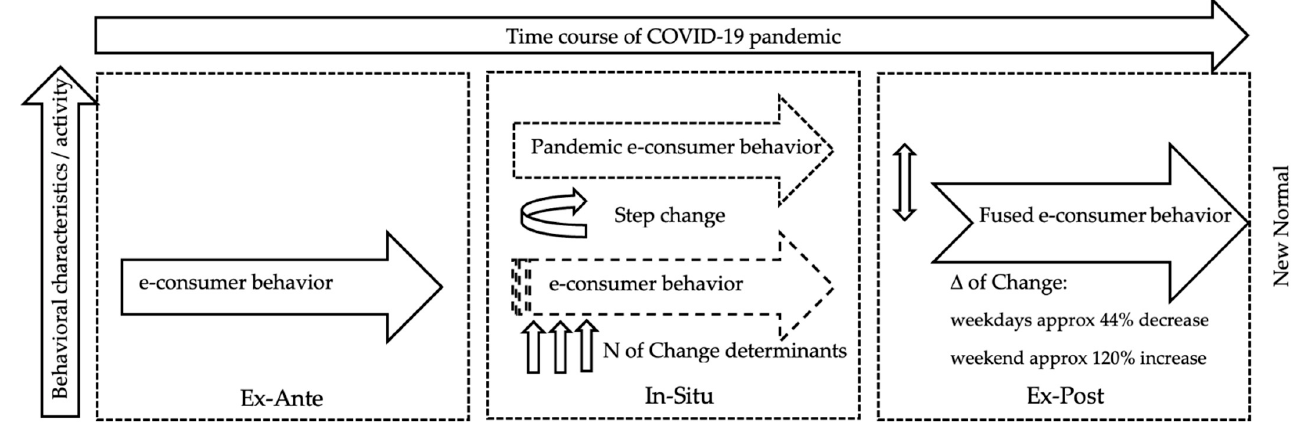
Figure 11. Empirical model of the impact of the COVID-19 pandemic on e-consumer behavior. Source: authors’ own processing based on [47].